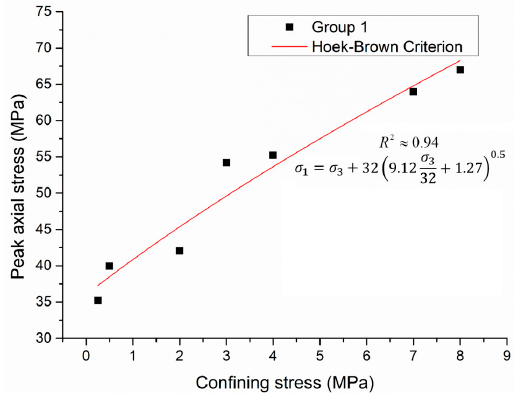
Figure 11. Strength property for Hoek-Brown failure criterion based on the peak axial stress at failure.